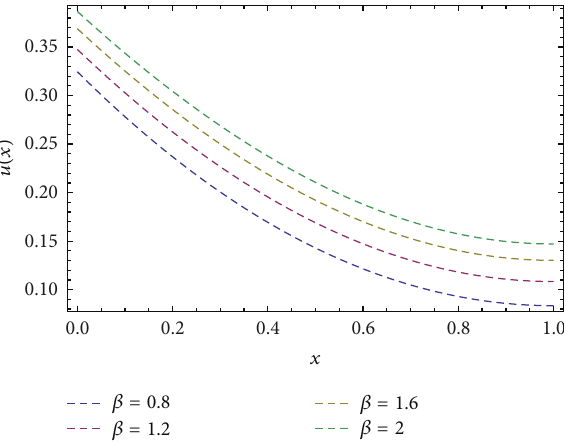
Figure 5: The influence of non-Newtonian 𝛽 on velocity profile for lifting problem keeping 𝛼 = 0.1 , 𝑚 = 0.5 , 𝑀 = 1 , and Λ = 0.4 . = −0.6221311197 , 1